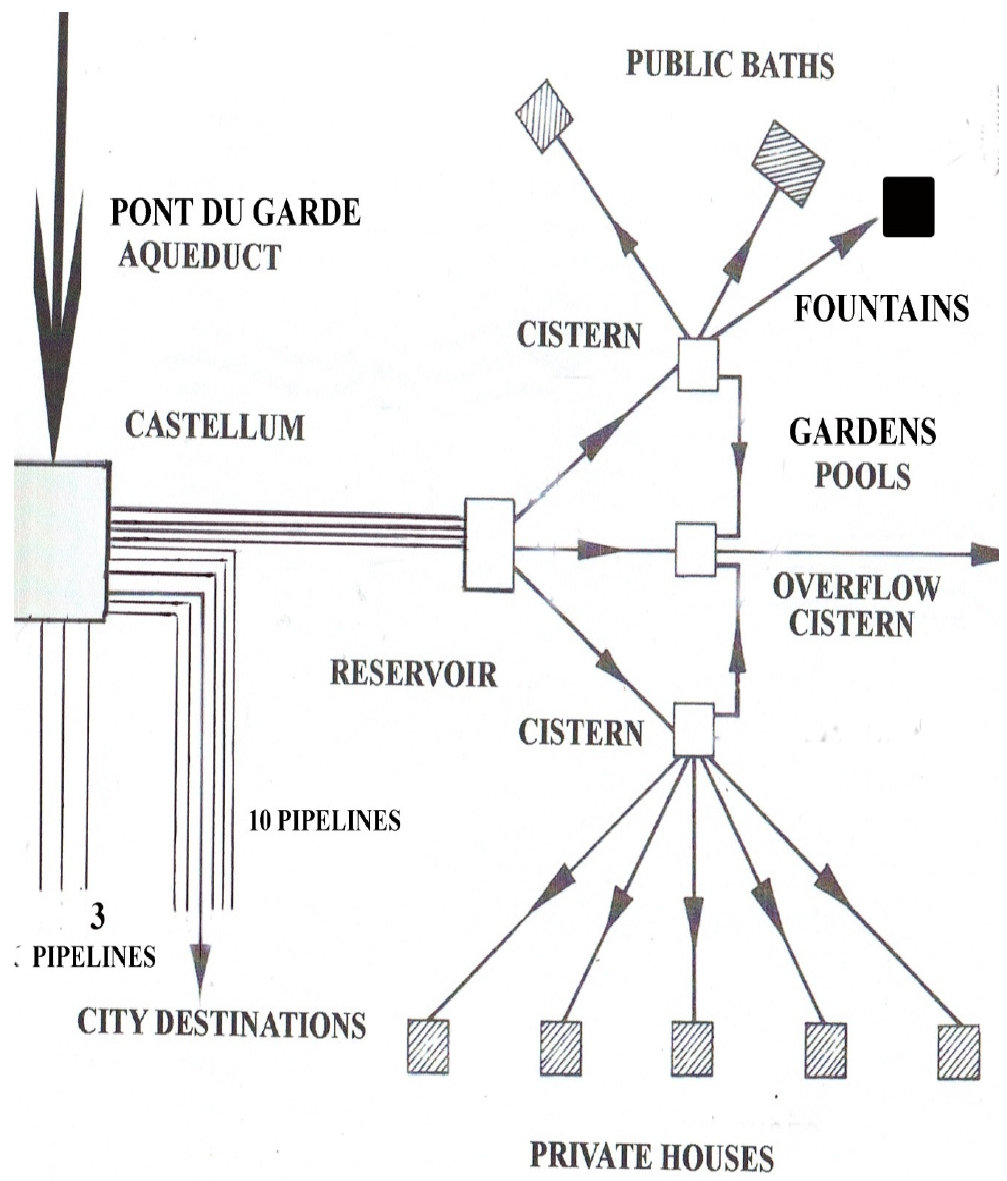
Figure 8. Aqueduct supplied water to the castellum showing the redistribution network structure typical of Roman cities.